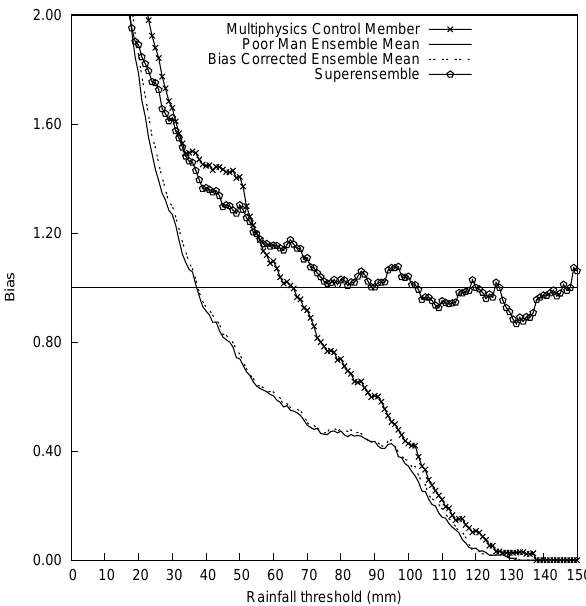
Fig. 3. Bias for the multiphysics ensemble control member, the multiphysics ensemble mean, the bias corrected ensemble mean and the superensemble, as functions of different rainfall event thresholds.